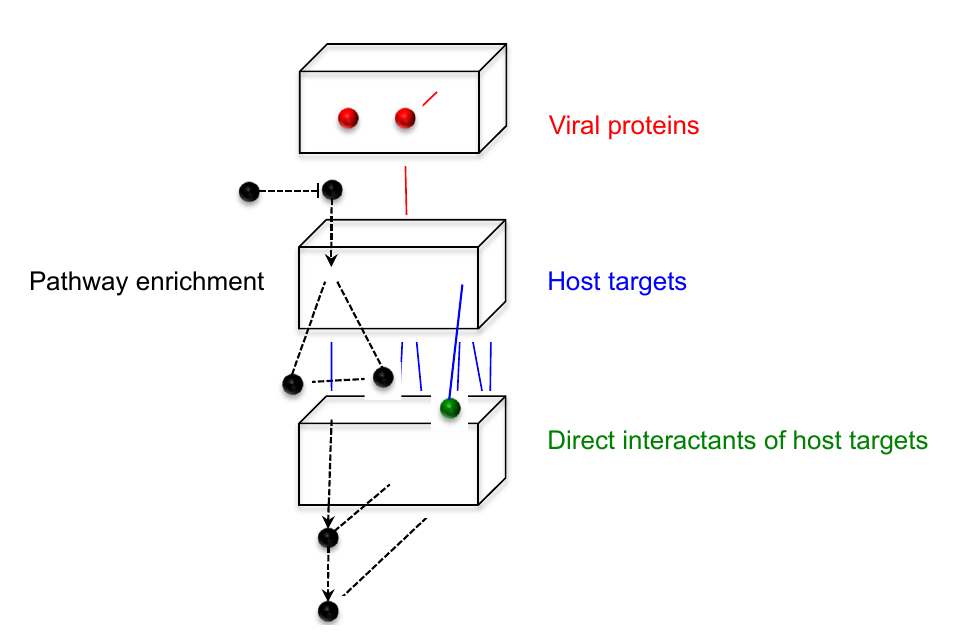
Figure 2. Construction of the arenavirus-host network. Schematic representation of steps in the construction of the arenavirus-host network. The four arenavirus proteins are represented by red nodes, host targets identified in the literature are blue nodes, and the directly interacting partners of these host targets, obtained from databases, are represented by green nodes. Black nodes represent proteins uploaded into the network through pathway enrichment performed on the host targets, and may contain, in addition to protein-protein interaction data, additional information about functional interactions between proteins. Edges indicate a relationship between two proteins, such as a direct protein-protein interaction or a process of protein modification, such as phosphorylation or